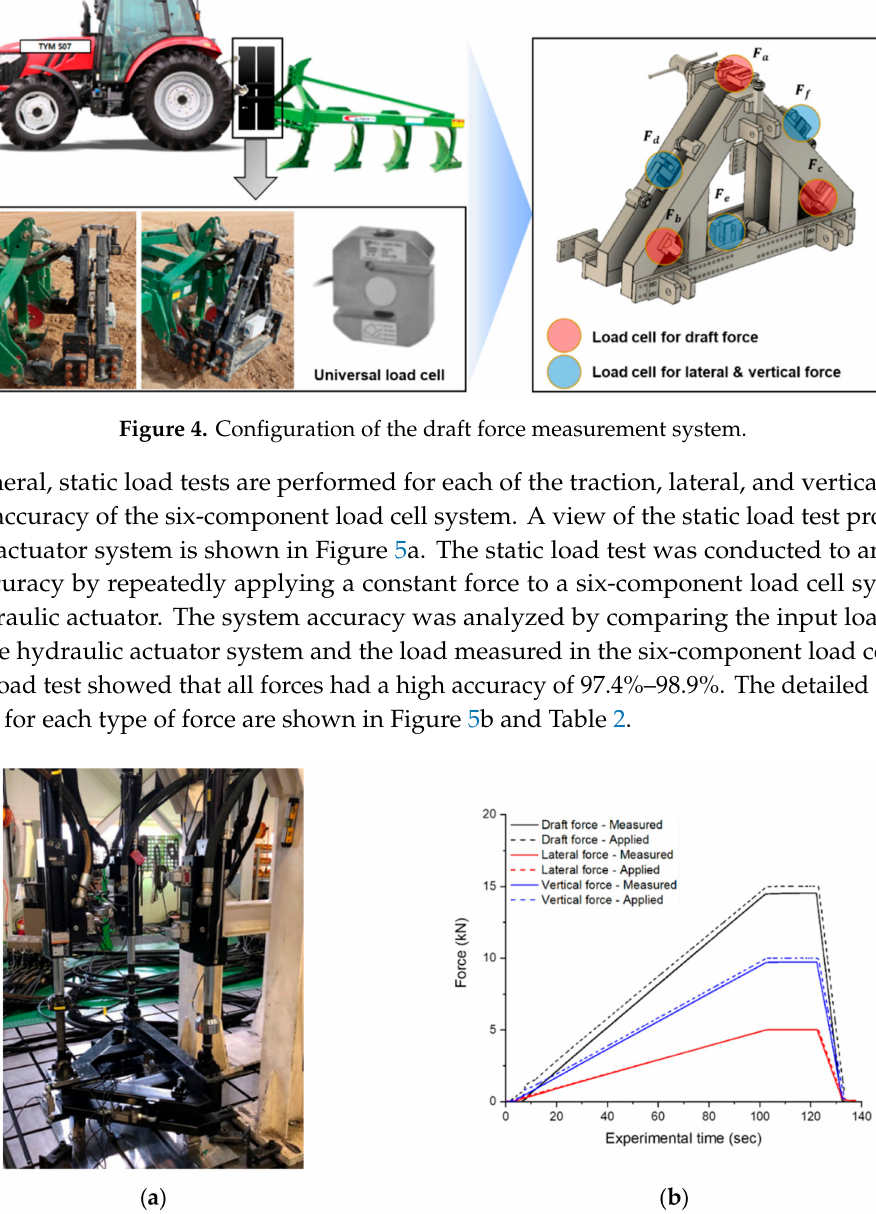
Figure 5. ( a ) Static load test for six-component load cell system; ( b ) test results of the static load